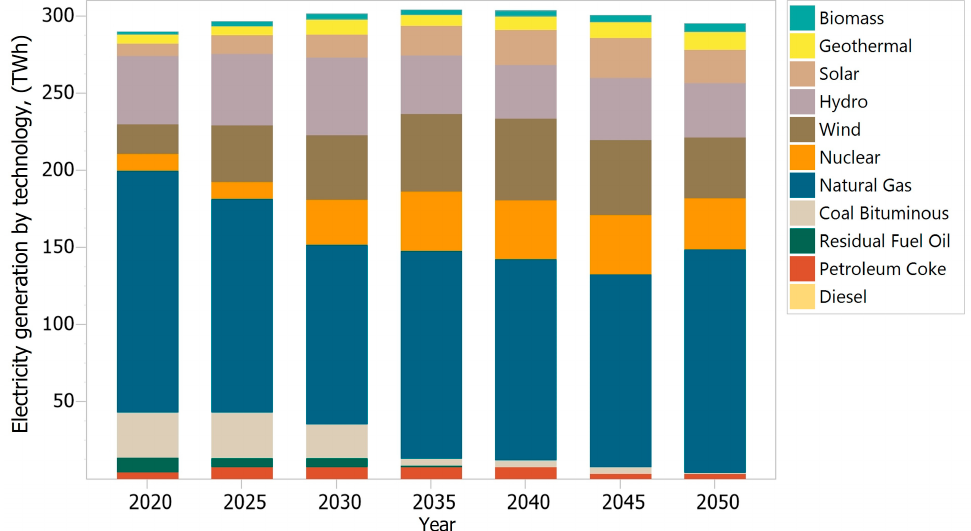
Figure 5. LVF-2.0 MWh scenario. Electricity generation by technology. Source: own elaboration with data from [7,29].